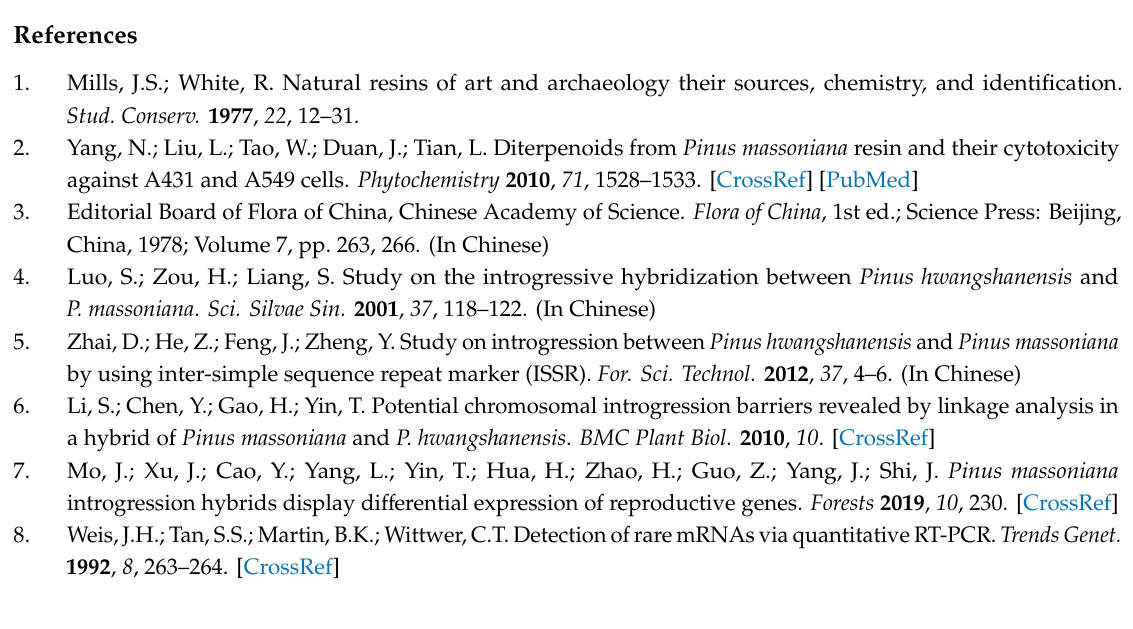
(MYN), Figure S5: cone of Z pine (ZCN), Figure S6: young stem of Z pine (ZYS), Figure S7: mature needle